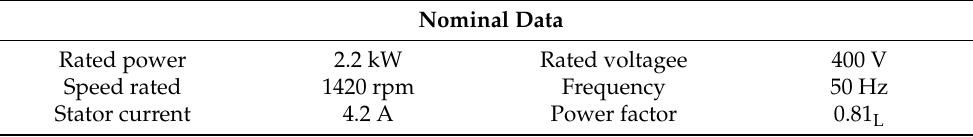
Table A2. Parameters of the MS 100L1-4 type induction